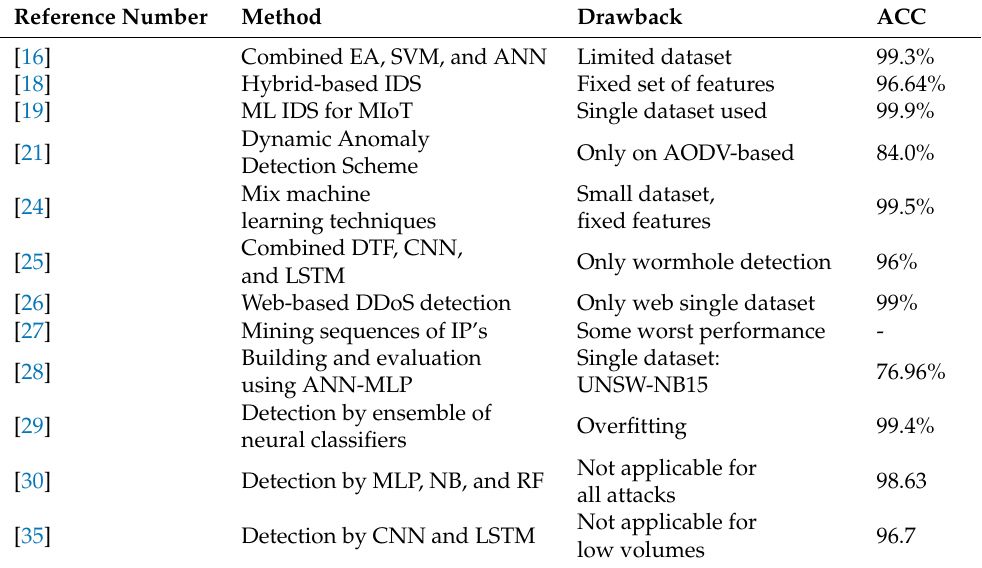
Table 1. Comparison of the